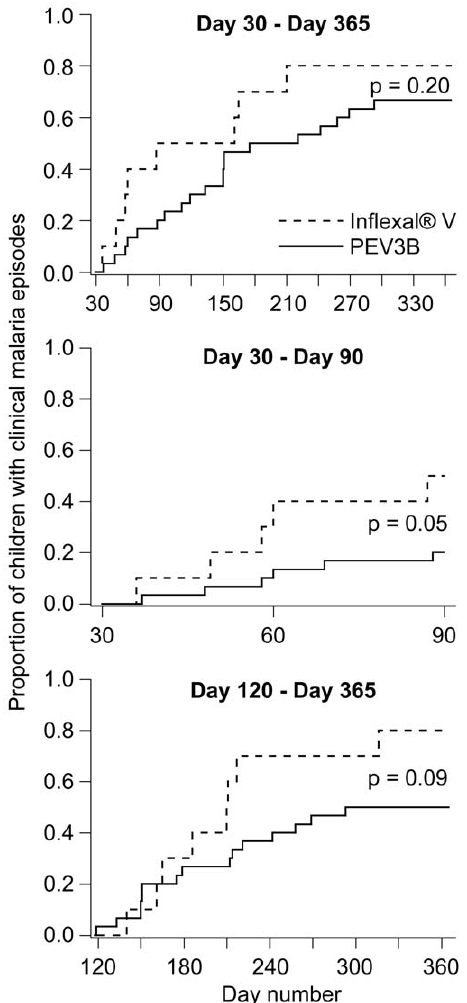
Figure 4. Attack rates of first or only clinical malaria episodes in vaccinated children. Kaplan-Meyer failure functions are shown for the intervals from 30 days after first vaccination (day 30) until the end of the study (day 365), from 30 days after first vaccination until second vaccination (day 90), and from 30 days after second vaccination (day 120) until study end (day 365). P-values for differences in failure functions between treatment groups are given (log-rank test). Note: the failure function in the third panel is not identical with the corresponding part of the failure function in the first panel, because of the occurrence of multiple events in the same individual during the course of the study.